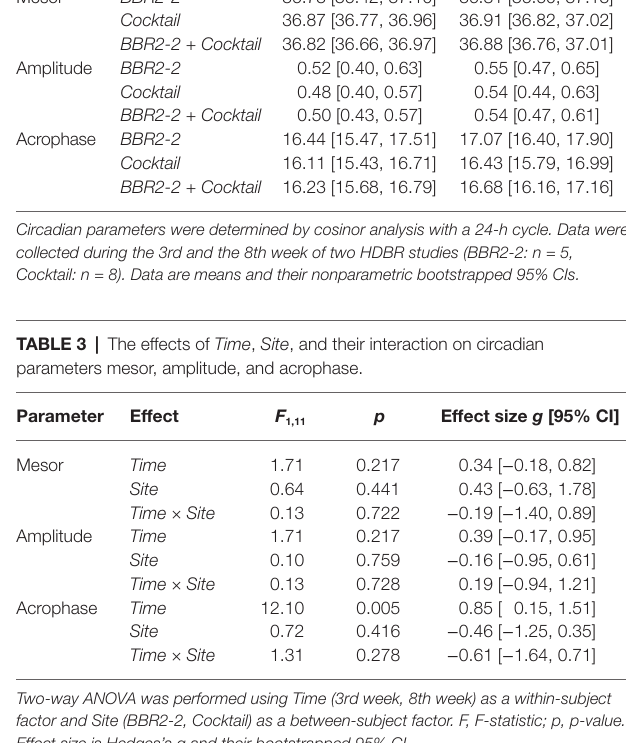
TABLE 2 | Effect of head-down tilt bed rest (HDBR) on core body temperature rhythm. Parameter Site